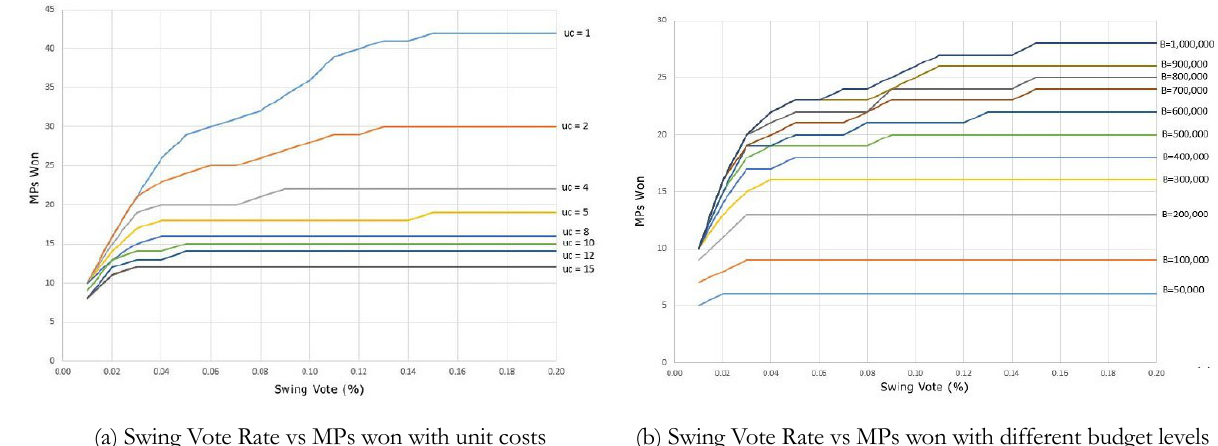
Figure 3. Effects of Swing Vote Rate on Number of MPs